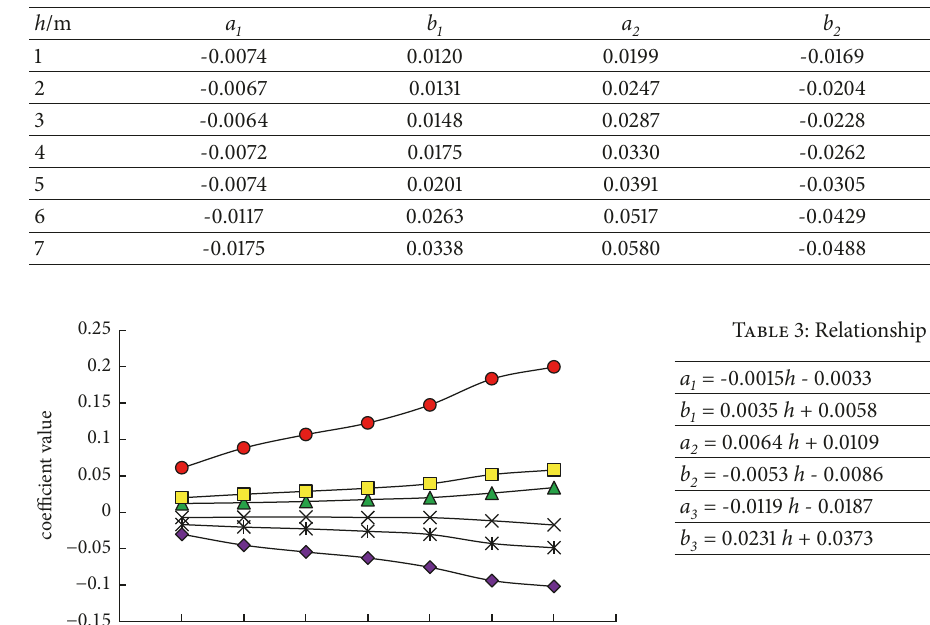
Table 2: Lateral pressure coefficient on lateral wall.